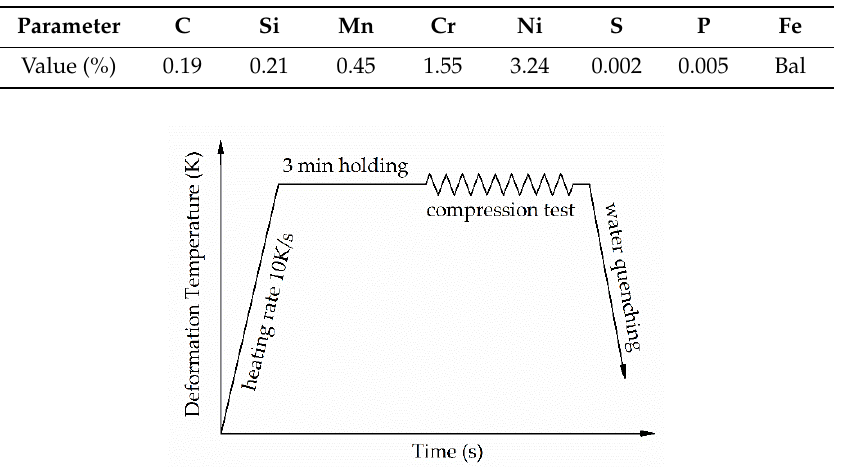
Figure 1. Flow chart of the isothermal hot compression.